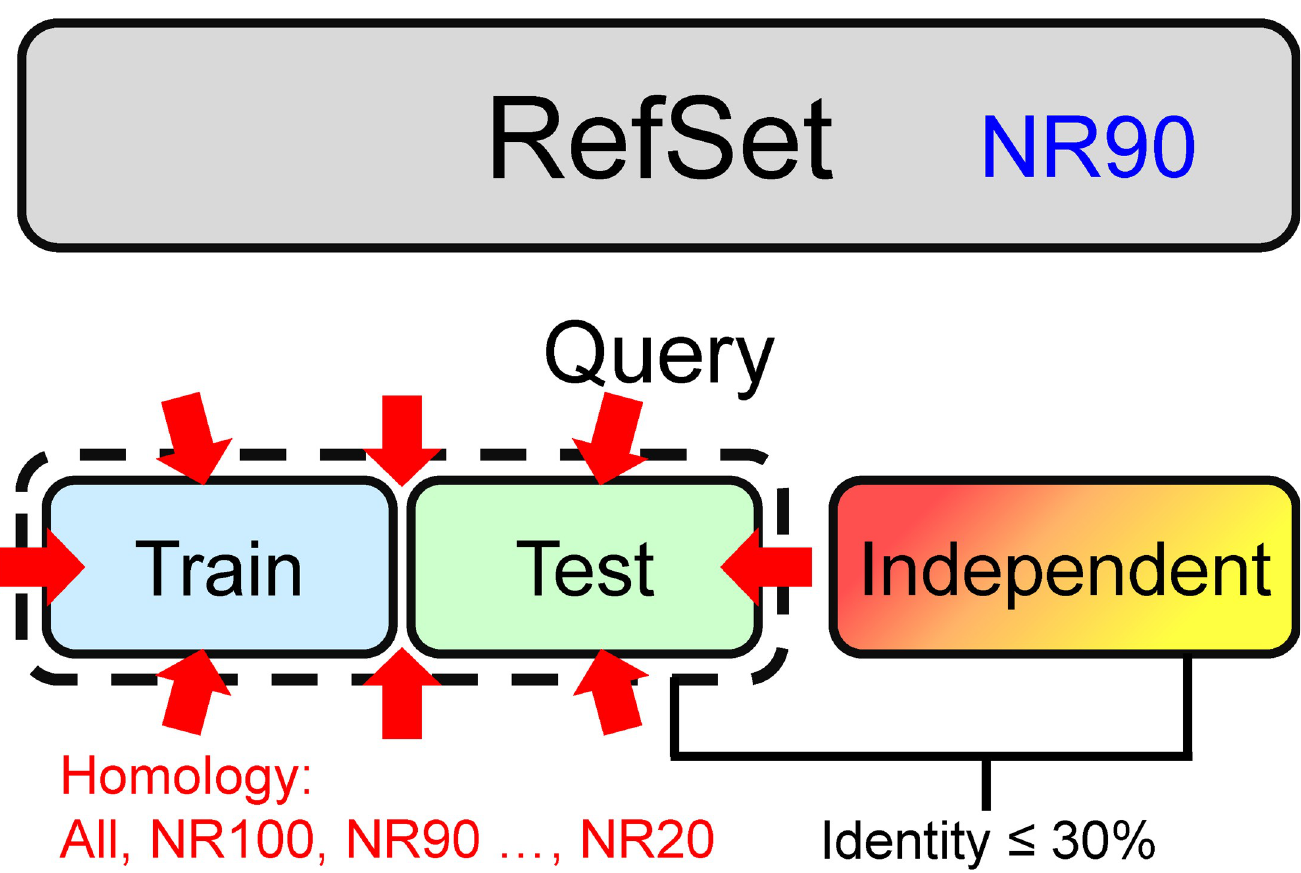
Fig 10. Experimental design for measuring the SSP accuracy of machine learning algorithms as the sequence homology of training and testing datasets decreases. In this layout, the PSSM reference set was a 90% sequence identity non-redundant dataset. The sequence homology of the source data of query sets was decreasing such that any sequences either in the same query set or between the training and testing query sets shared homology lower than the given identity cutoffs. The “All” means that the homology reduction is not applied, or otherwise, the number after “NR” indicates the identity cutoff of the homology reduction. Proteins in the reference dataset and training/testing query sets were obtained from the Pdb-2015. The query sets for independent tests were TS115, CASP12/13, and TS416.